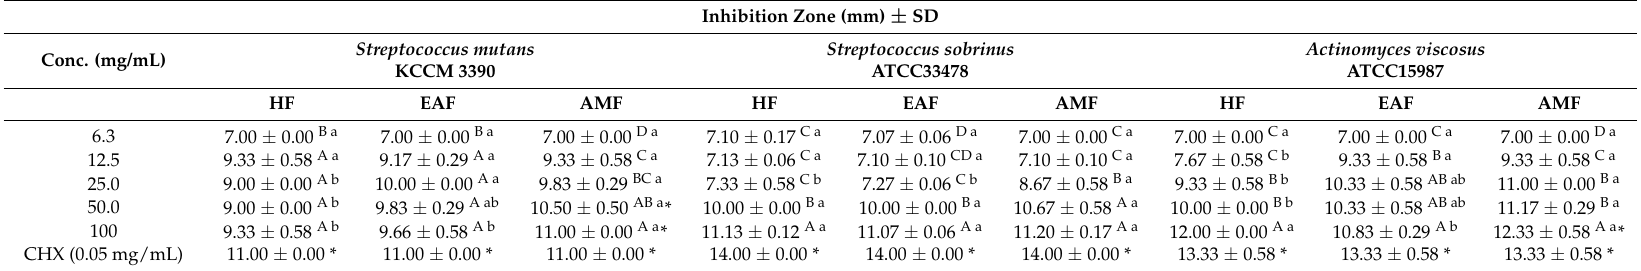
Table 5. Disc diffusion assay of P. cubeba L. fractions against oral